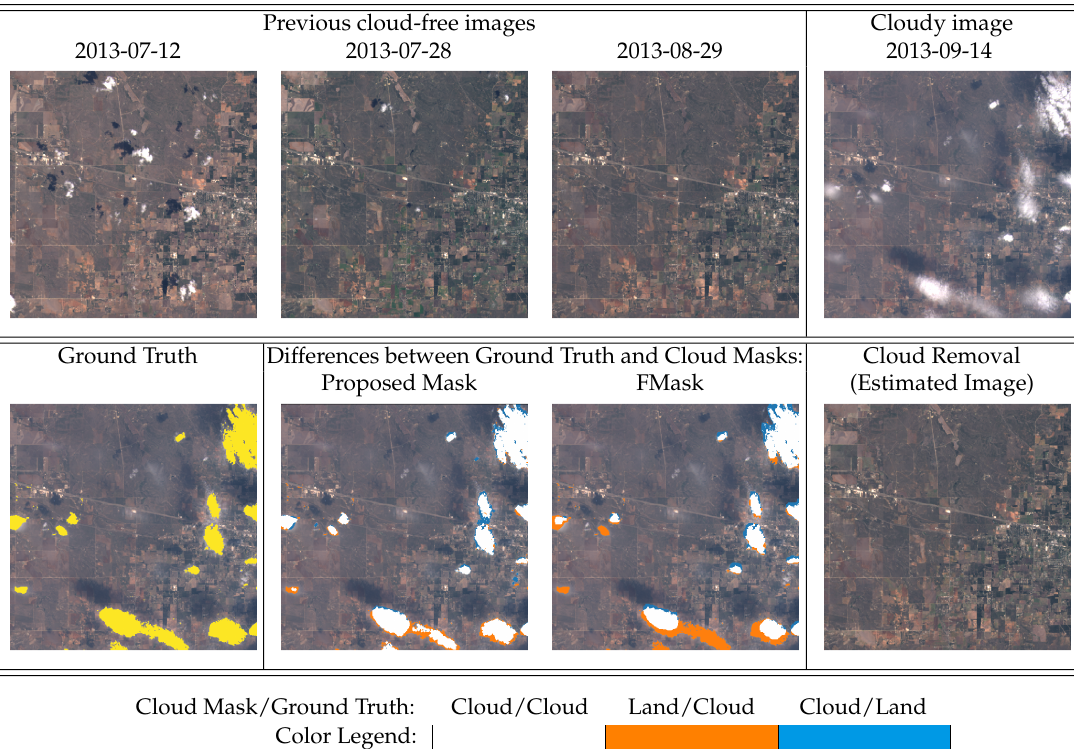
Figure 3. Illustration of the Cloud detection scheme. Comparison between the ground truth and the proposed cloud mask algorithm and the FMask. Discrepancies are shown in blue when the proposed method detects ‘cloudy’, and in orange when pixels are classified as